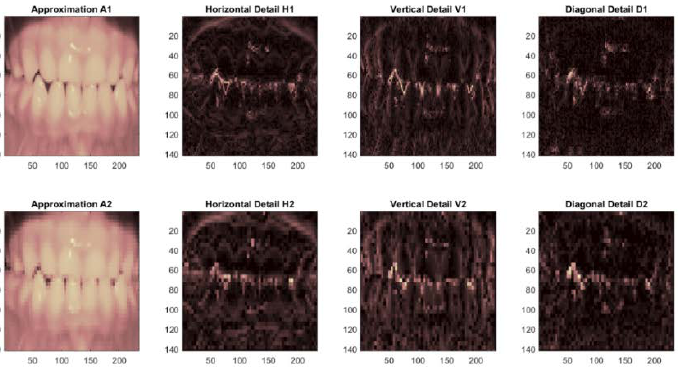
Figure 7. The extraction of the first and second levels of the approximation coefficients and detail coefficients.